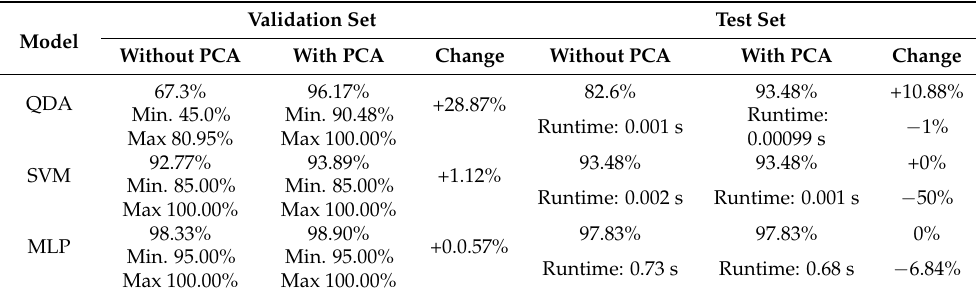
Table 4. Performance summary for validation and test